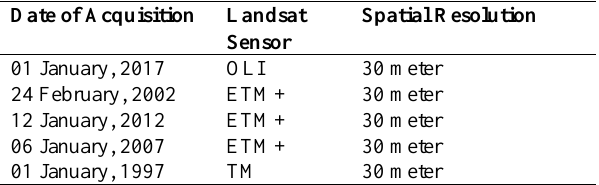
Table 2 highlights the LULC features included for each class. Table 1. Characteristics of Landsat data sets for the study.